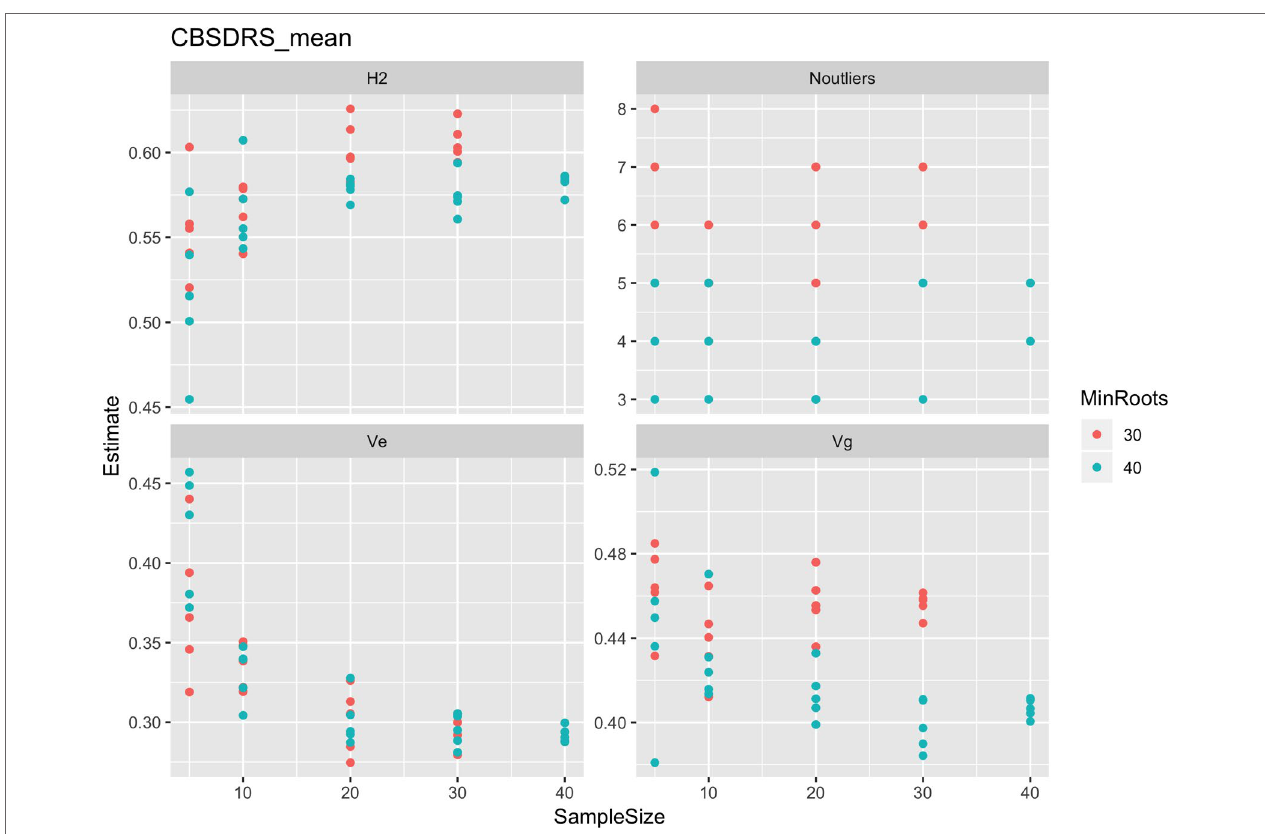
FiGURe 4 | Influence of root sample sizes on CBSD mean root necrosis severity. H 2 , broad-sense heritability; Ve, error variance component; Vg, genetic variance component; Noutliers, number of outliers. Analysis based on resampling of 5, 10, 20, 30, or 40 roots from each plot at random.